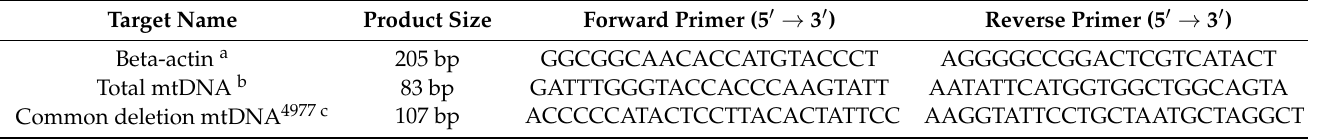
Table 1. Primer sets used for quantitative PCR; a from Li [49], b and c from Koch